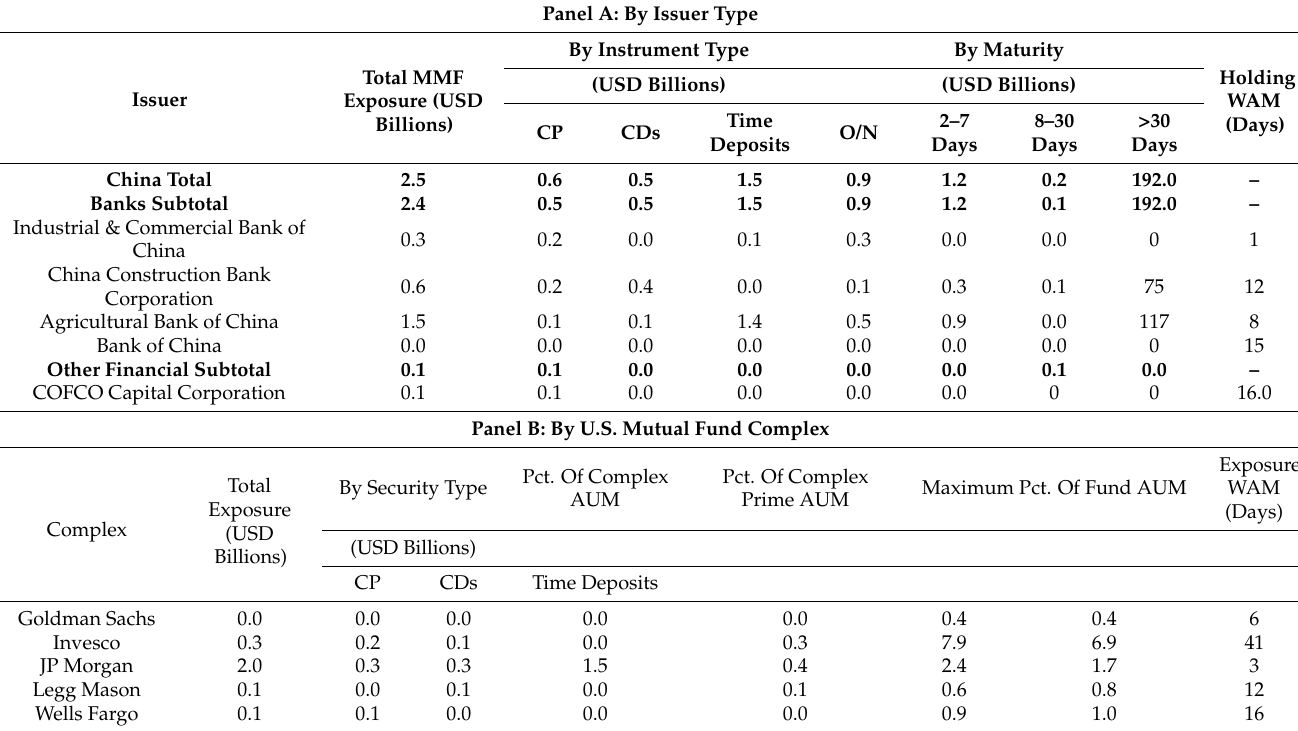
Table 5. Exposures of U.S. MMFs to